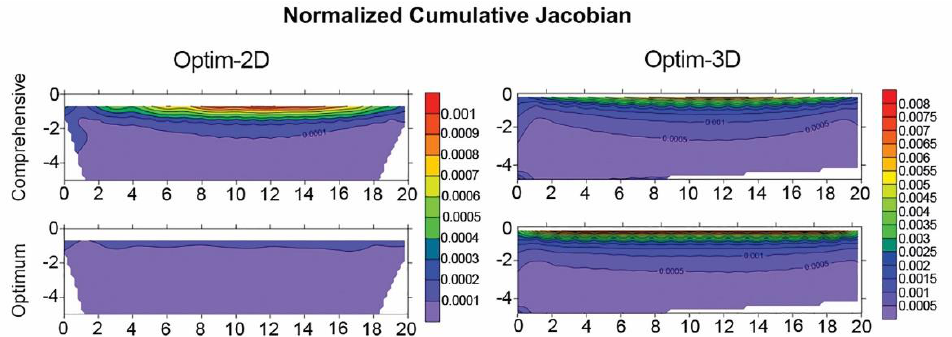
Figure 5. Normalized cumulative sensitivity results along a 2-D section for the comprehensive and optimum 3-D data sets resulted by the “optim-2D” and “optim-3D” strategy. Different scaling is used for presentation purposes since the sensitivity values differ.